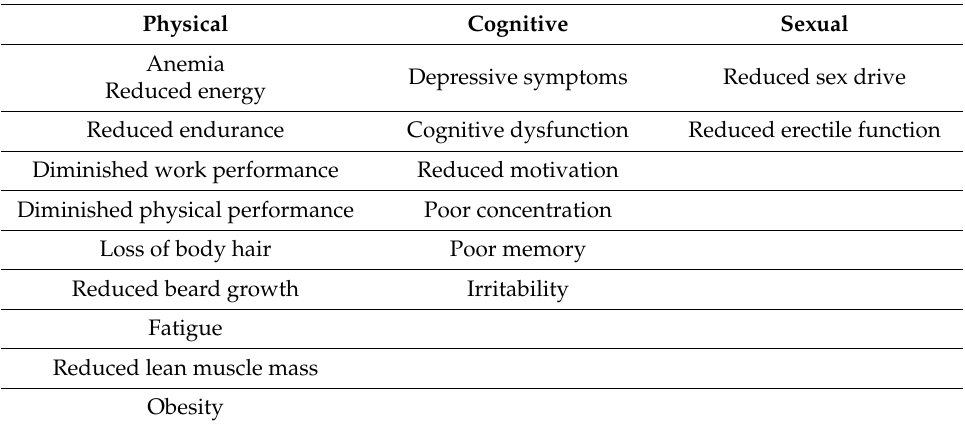
Table 1. Symptoms and signs associated with